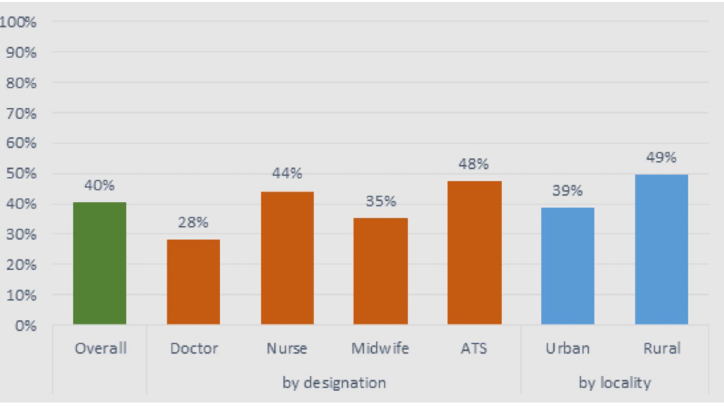
Fig 1. Proportion of health workers who practised in rural areas during training, by health workers